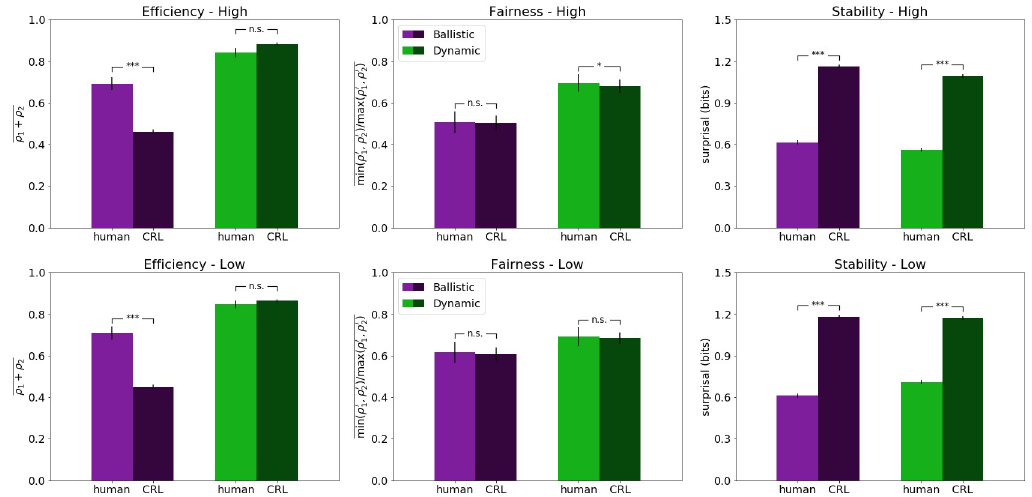
Fig 5. Pairwise comparison between model and human results in the Battle of the Exes game. The top panel shows the results on the high-payoff condition. The bottom panel shows the results on the low-payoff condition. Within each panel, blue bars represent the results in the ballistic condition, and red bars represent the results in the dynamic condition. Human data from [23]. All error bars reflect standard errors.